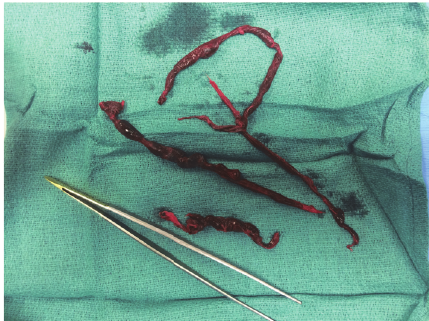
Figure 5: Clot retrieved at embolectomy.